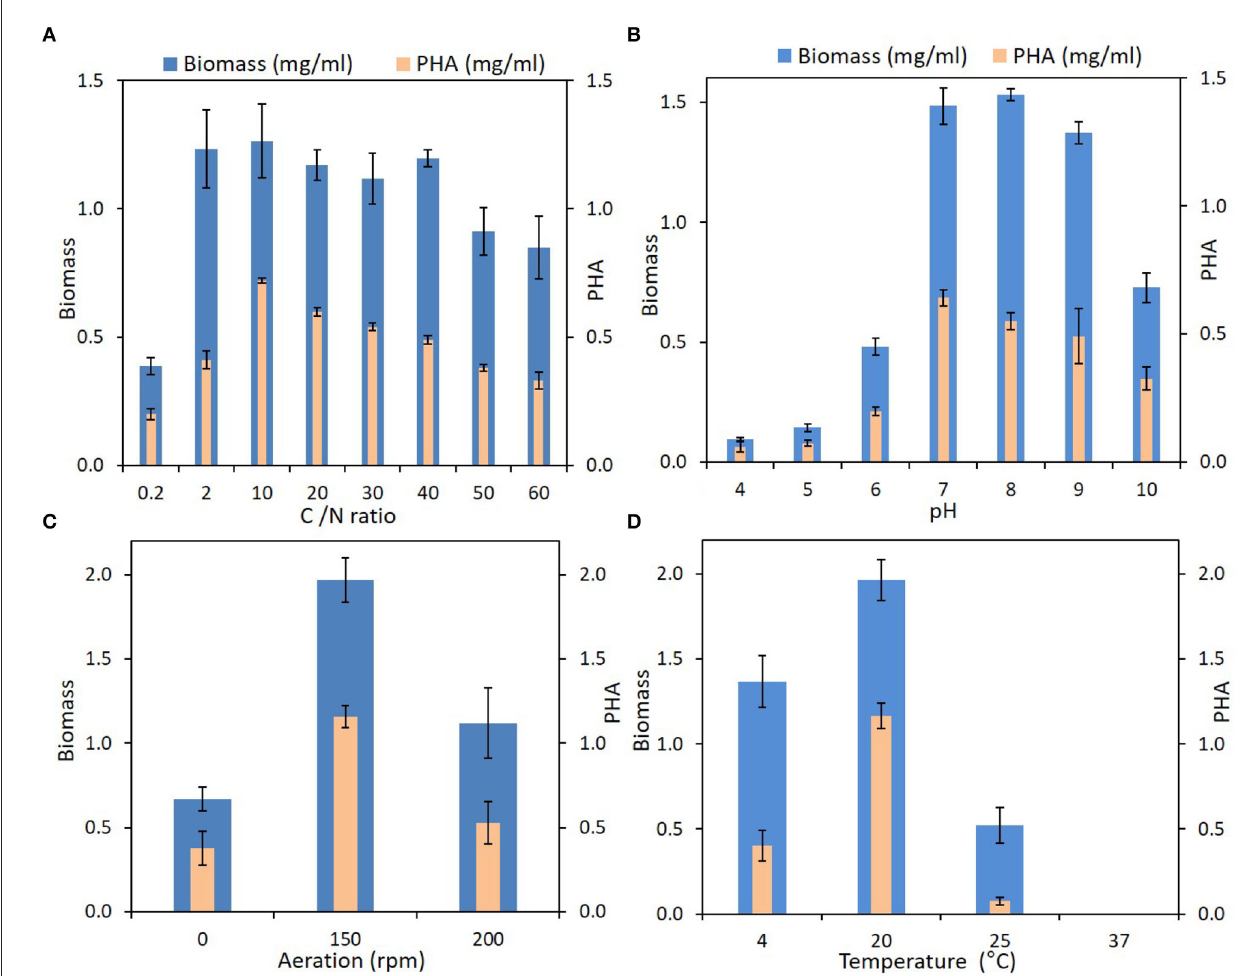
FIGURE 4 | PHA production by Iodobacter sp. PCH194 at different physicochemical and environmental conditions. (A) Carbon to nitrogen (g/g) ratio, (B) pH, (C) aeration, and (D) temperature. discuss multiple adaptive strategies of Iodobacter sp.